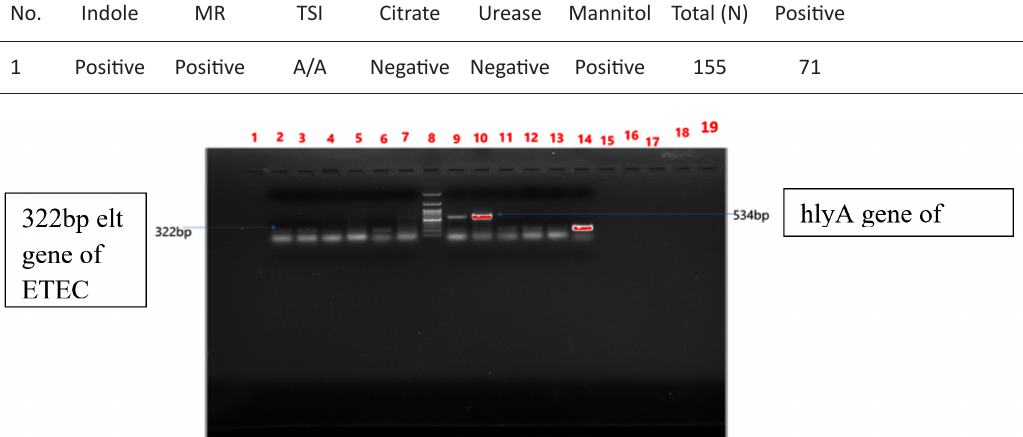
Table 1. Biochemical test applied for screening of E. coli in paediatric patients No.